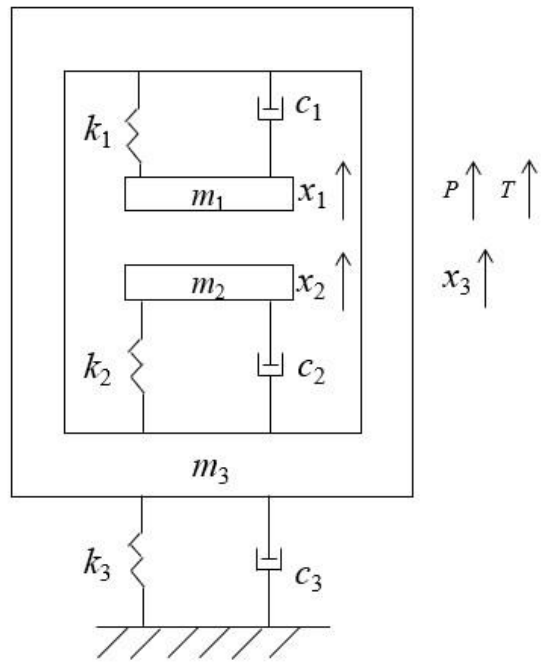
Figure 2. The dynamics model of a T630 COF machine.